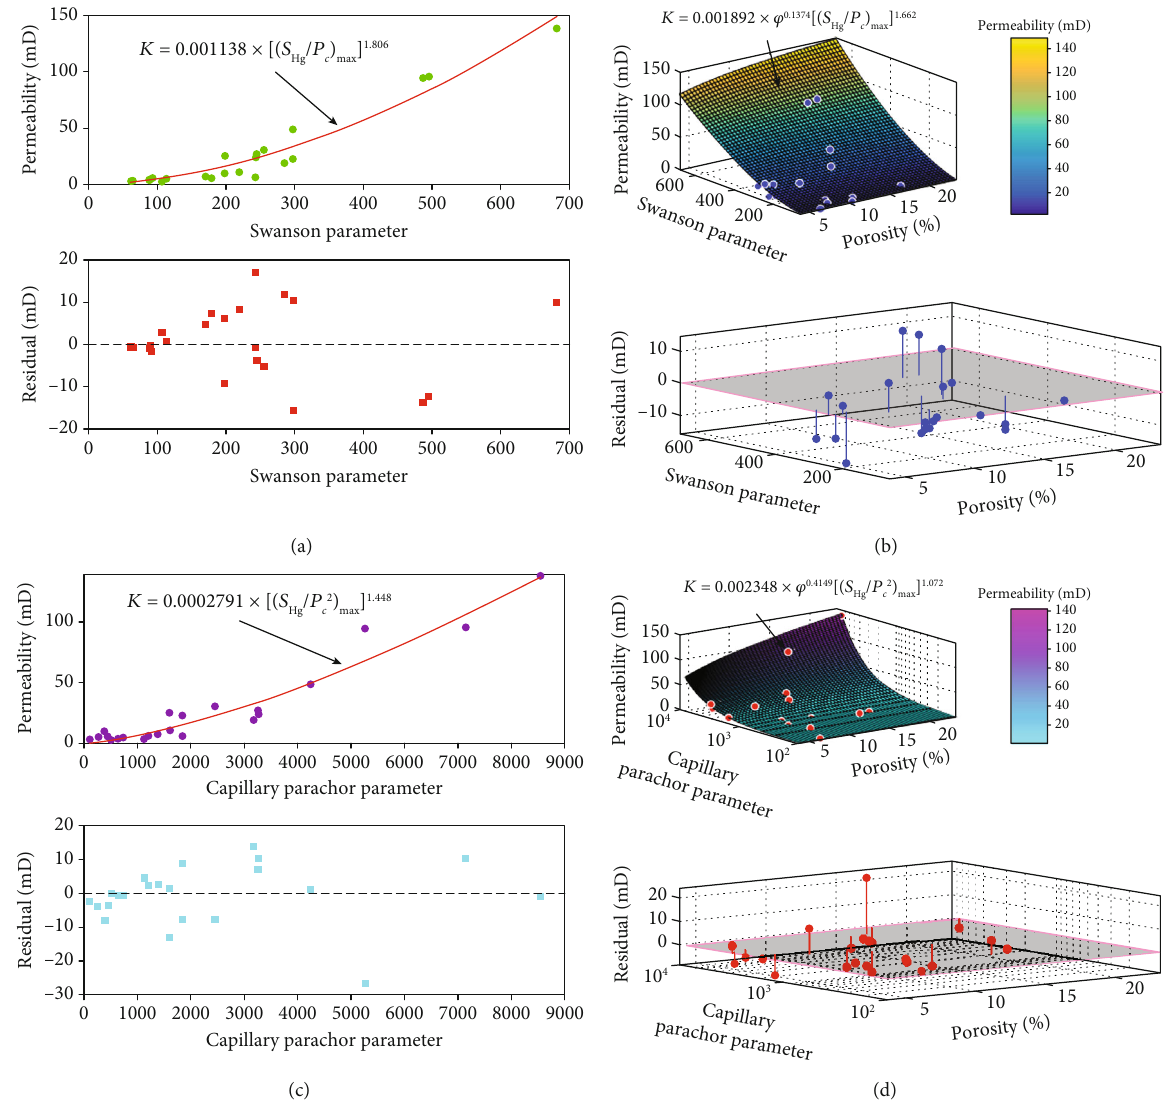
Figure 7: Visualization of the fi nal results of the Swanson parameter-based models and capillary parachor parameter-based model: (a) Swanson model; (b) improved Swanson model; (c) capillary parachor model; (d) improved capillary parachor